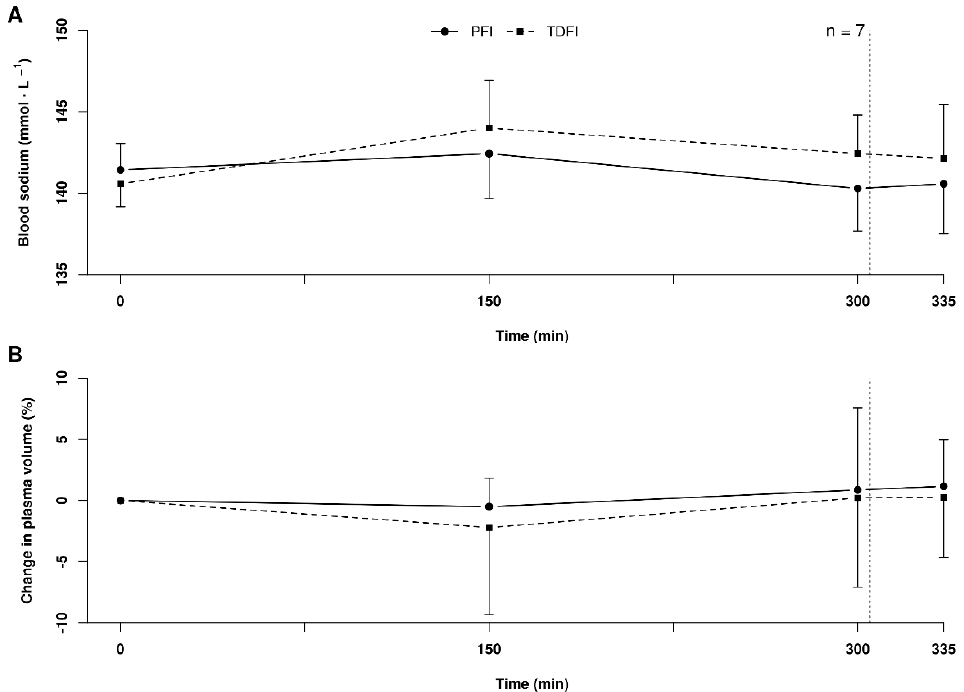
Figure 3. Blood sodium concentrations ( A ) and plasma volume variations ( B ) during the 5 h fixed- workload exercise period and at the end of the 20 km time-trial for the programmed (PFI) and thirst-driven fluid intake (TDFI) strategies. Vertical dotted line represents the onset of the time-trial. Values are means ± SD.